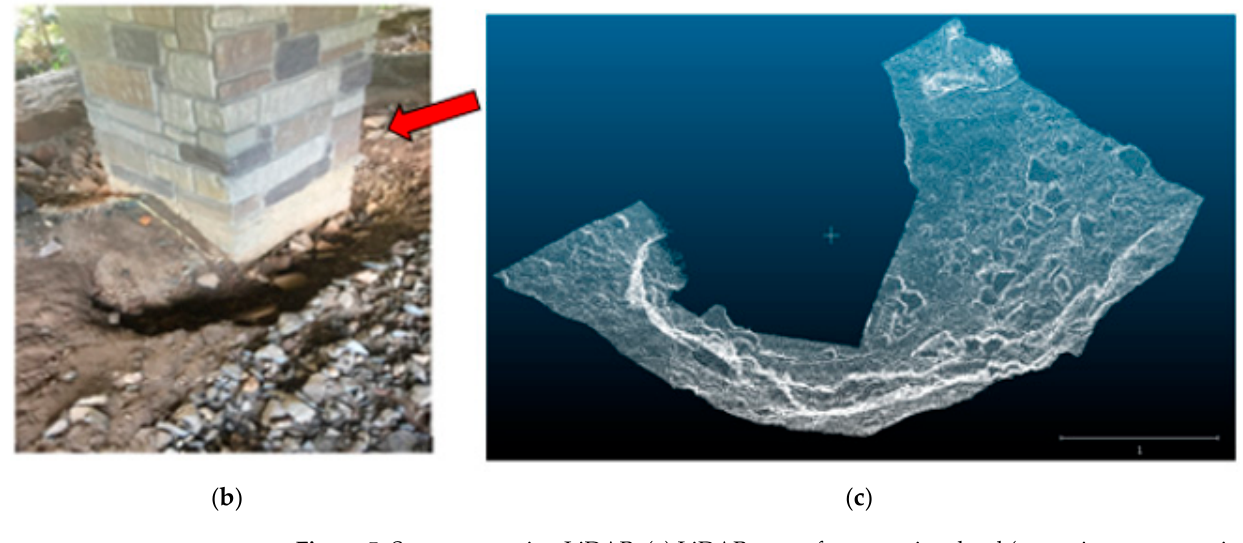
Figure 5. Scour scan using LiDAR: ( a ) LiDAR scan of scour point cloud (not a river cross-section)— 1.5 m; ( b ) image of scour hole (Pier 1); ( c ) scour hole point clouds looking from the direction of arrow in ( b ) (photo credit: S.E. Chen).